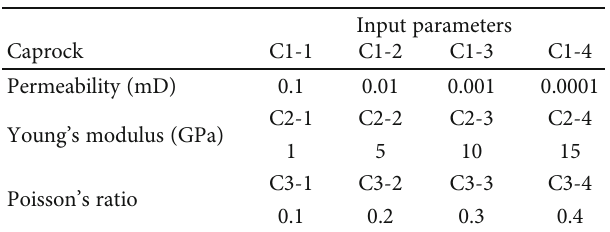
Table 6: Input parameters of scenario